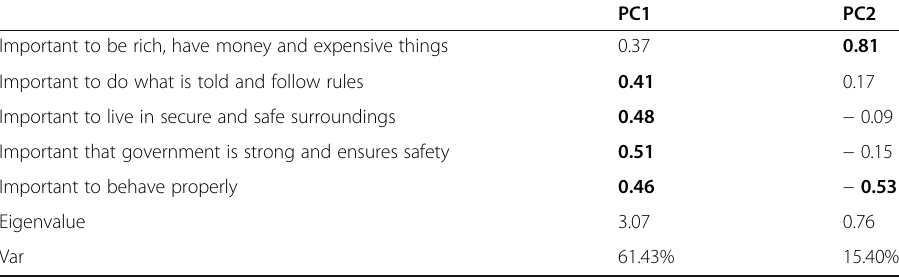
Table 6 PCA for hierarchy vs egalitarianism